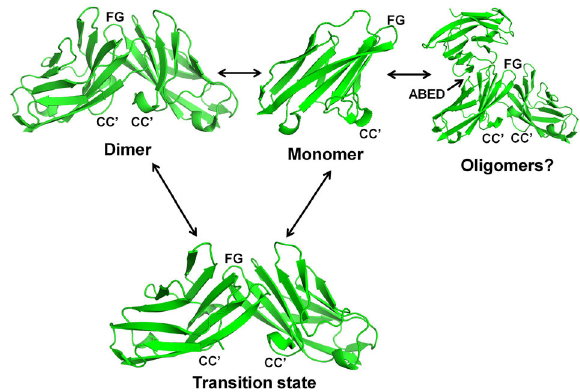
Fig. 9 Dynamic human CEACAM1 monomer – dimer